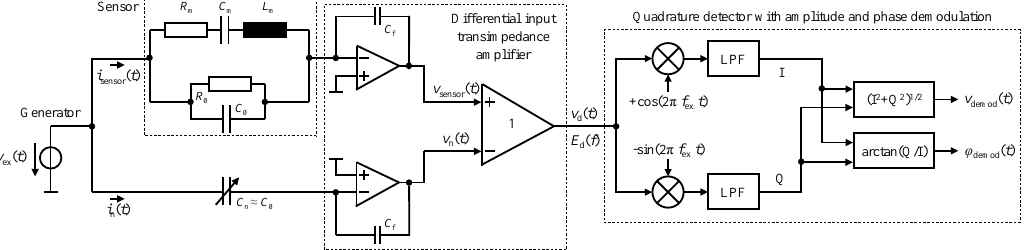
Figure 3. Electrical readout system for the measurement of a physical quantity (here, a magnetic flux density) that affects the resonance frequency of an electromechanical resonator. The sensor is driven in the vicinity of its resonance frequency by an electrical excitation signal v ex ( t ) , leading to an amplitude- modulated and phase-modulated signal v d ( t ) at the output of a differential input transimpedance amplifier. A subsequent quadrature detector performs both the amplitude demodulation and the phase